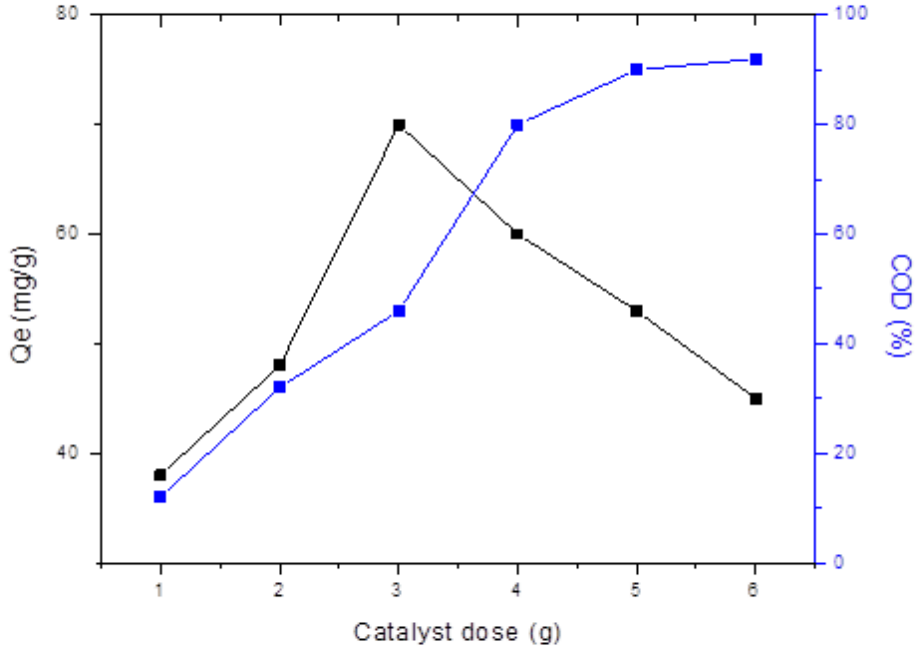
Figure 12. Effect of catalyst (Fe 3 O 4 NHS) concentration on the adsorption capacity ( Qe ) and % decrease in COD values of TNT wastewater (TNT volume is 0.05 L at room temp. and pH value